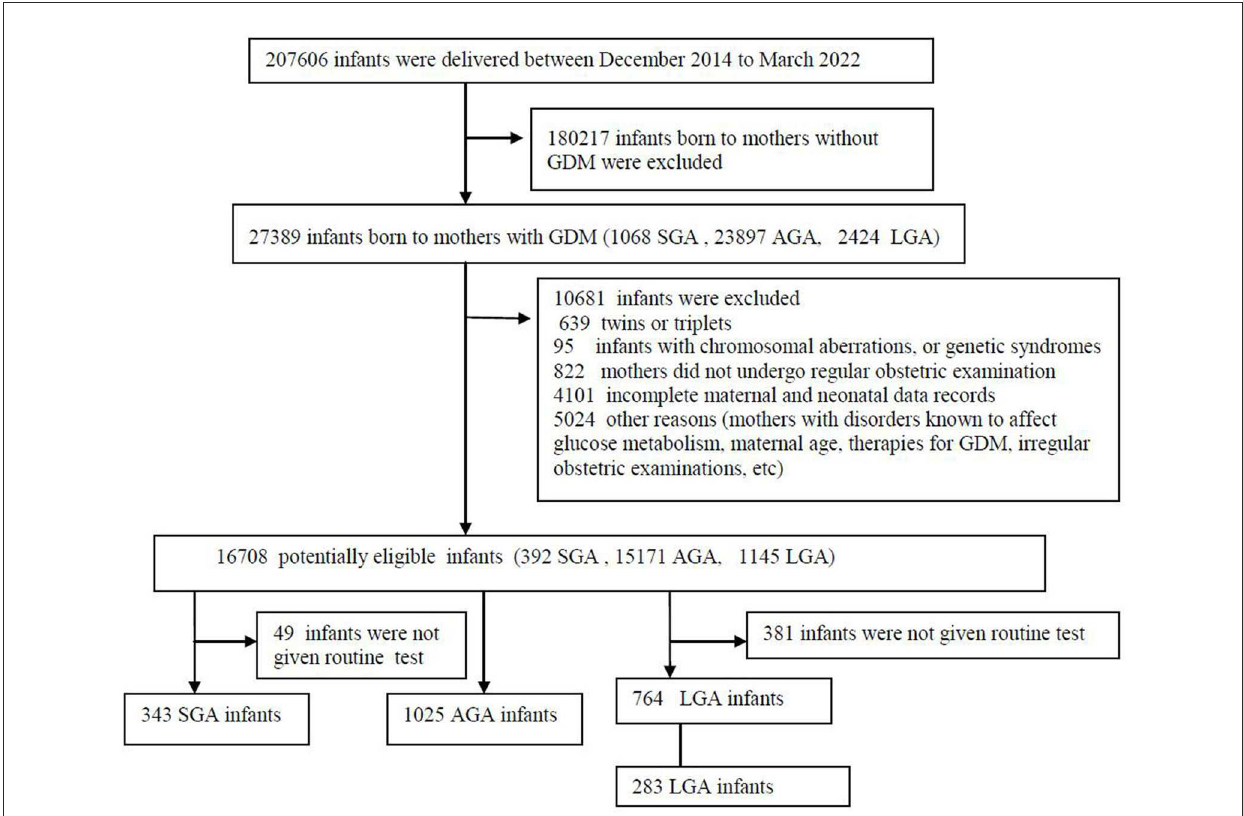
FIGURE1 Flow diagram of study population. AGA, appropriate for gestational-age; GDM, gestational diabetes mellitus; LGA, large-for-gestational-age; SGA, small for gestational